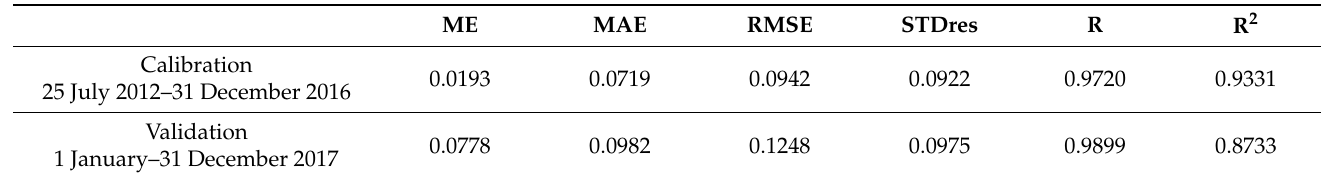
Table 3. Values of statistical criteria used for the evaluation of the Lake Zazari basin hydrological model performance.